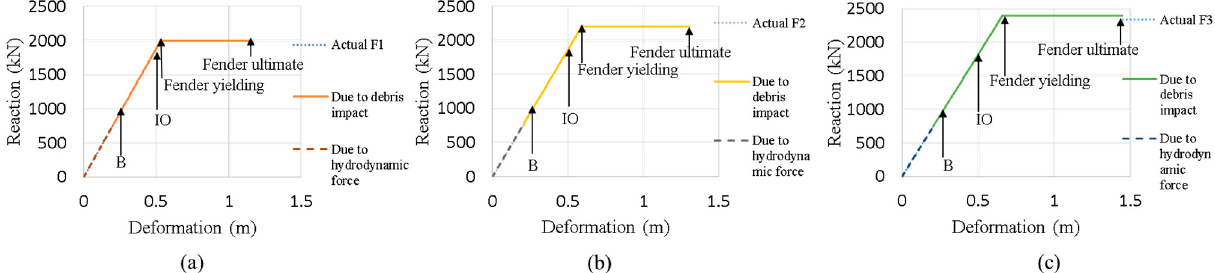
Figure 14. Load-deformation relations of fenders at various states: ( a ) Fender F1, ( b ) Fender F2, and ( c ) Fender F3.